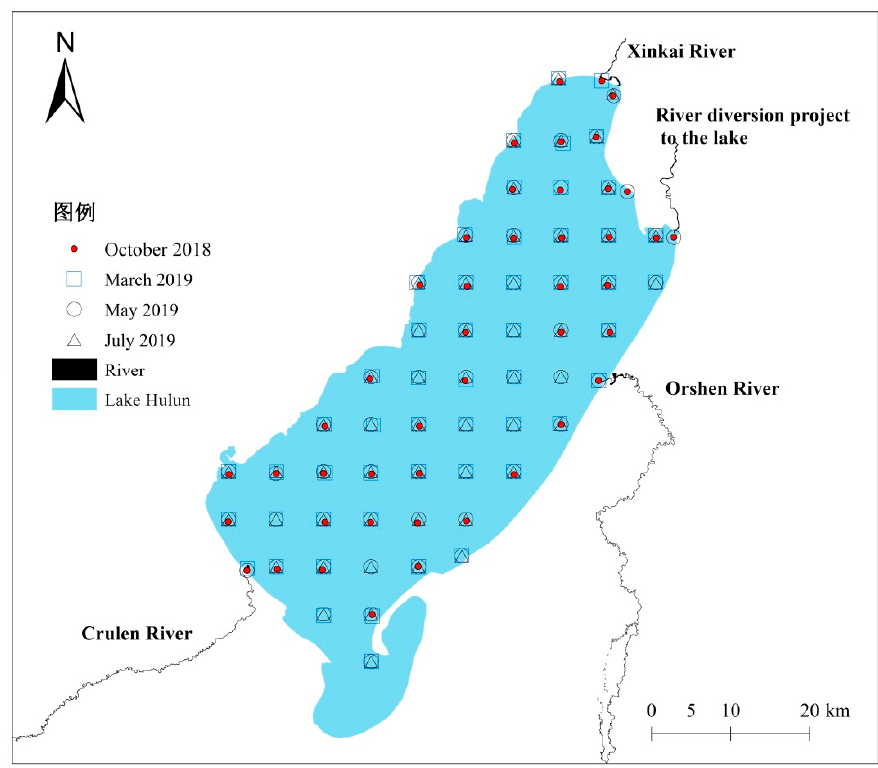
Figure 1. Location of the sampling sites.